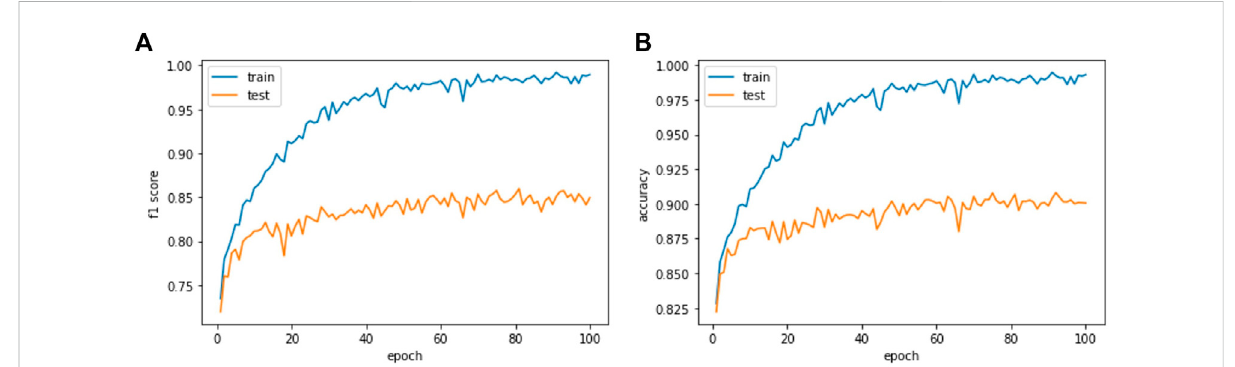
FIGURE 2 Learning curve of our model. (A) shows learning curve with F1 score. (B) shows learning curve with accuracy. The performance converges around 100 epoch.